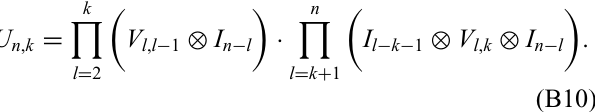
FIG. 17. A circuit that yields the unitary operator given by Eq. (B12).